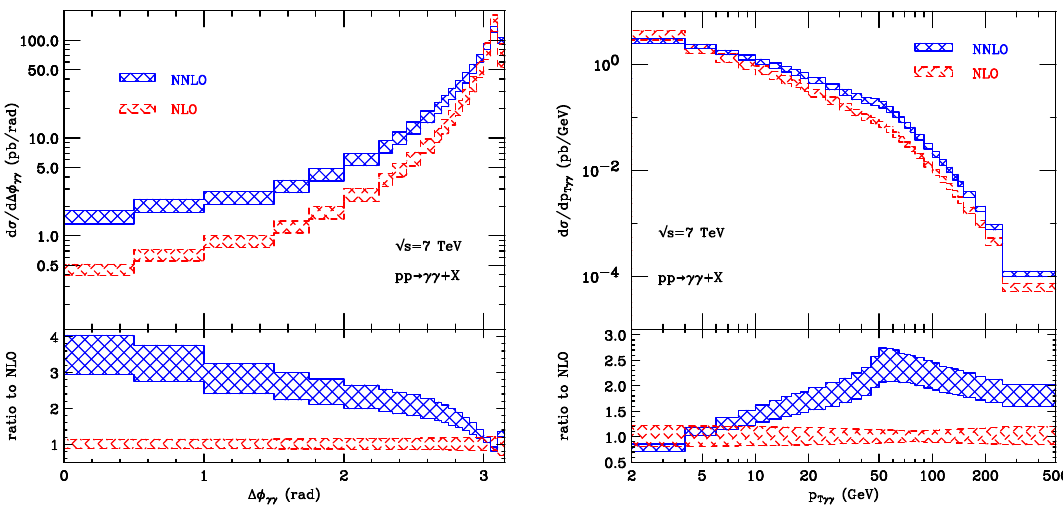
Figure 13 . The differential cross sections dσ/d ∆Φ γγ (left) and dσ/dp Tγγ (right). The NLO and NNLO results are analogous to those in figure